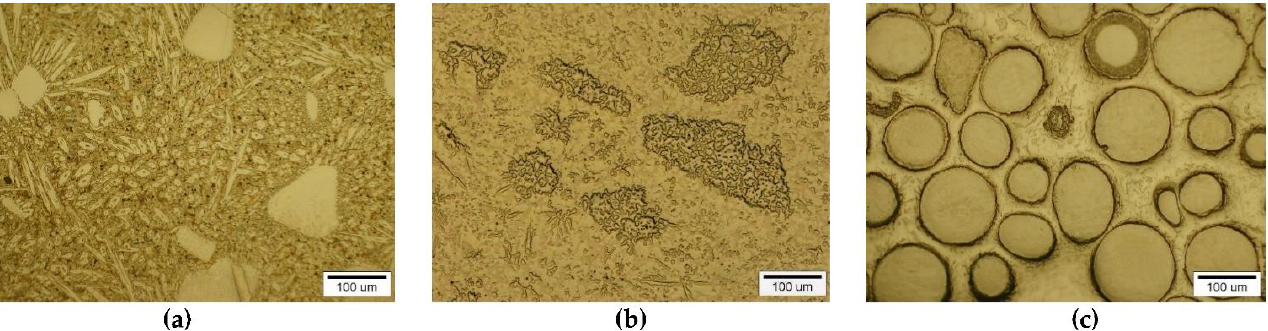
Figure 11. Structure of PTAW obtained composite overlays on NiBSi alloy basis reinforced with Cr 3 C 2 ( a ), Mo 2 C ( b ) and WC ( c ) particles.